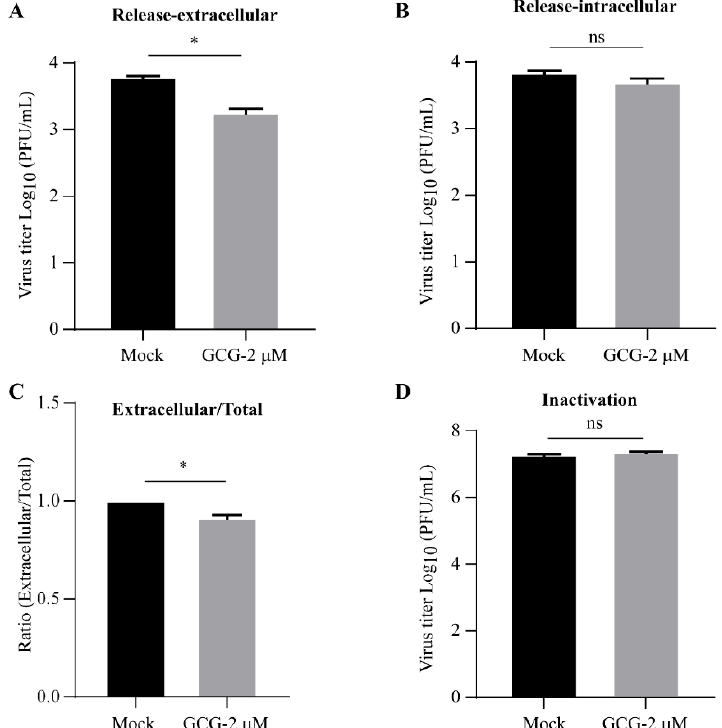
Figure 5. Gallocatechin gallate could suppress the release stage of PRV and was unable to inactivate PRV directly. ( A – C ) Gallocatechin gallate inhibited the release of PRV. PK15 cells were infected with JSY13 (1 MOI) in serum-free DMEM and incubated at 37 °C for 1 h. Then, the medium was changed into DMEM containing 2% FBS and incubated at 37 °C for 2 h. The cells were treated with gallocatechin gallate (2 μ M) and incubated at 37 °C for 1 h. The viruses in the supernatant ( A ) and cells ( B ) were titered using a plaque formation assay, respectively. ( C ) The ratio of the extracellular PRV to the total amount was calculated to measure the release percentage of PRV. ( D ) JSY13 (200 μ L) was mixed with 2 μ M gallocatechin gallate and incubated at 37 °C for 1 h, and the virus titer was measured using a plaque formation assay. (ns, not significant; *, p < 0.05).